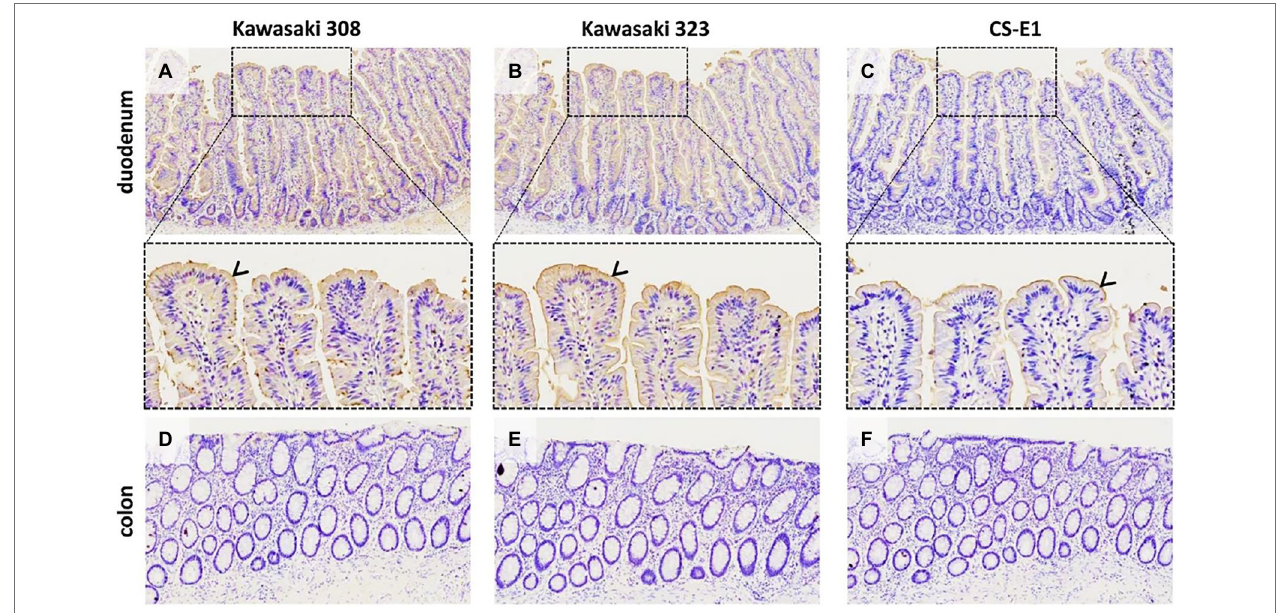
FIGURE 7 | GII.17 attachment on duodenal and colonic histological sections from a AB blood group patient (magnification x100 for the first and last line). Duodenum (panels A–C ) and distal colon (panels D–F ) are indicated on the left side of each line. Arrowheads indicate VLP binding on the epithelium, for which is characterized by brown staining. For the duodenum, magnified areas are indicated by dashed boxes (magnification x400). GII.17 variants are indicated above the